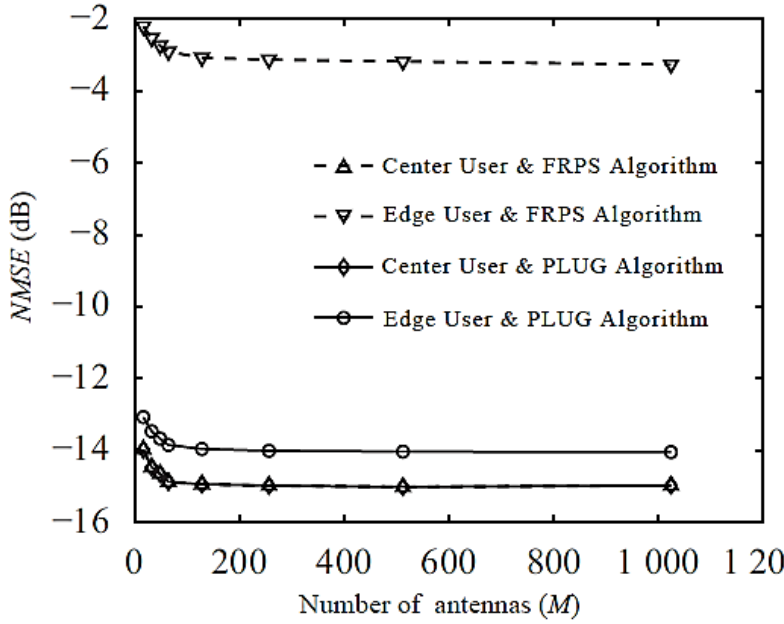
Figure 8. NMSE comparison of FRPS and PLUG Algorithms.